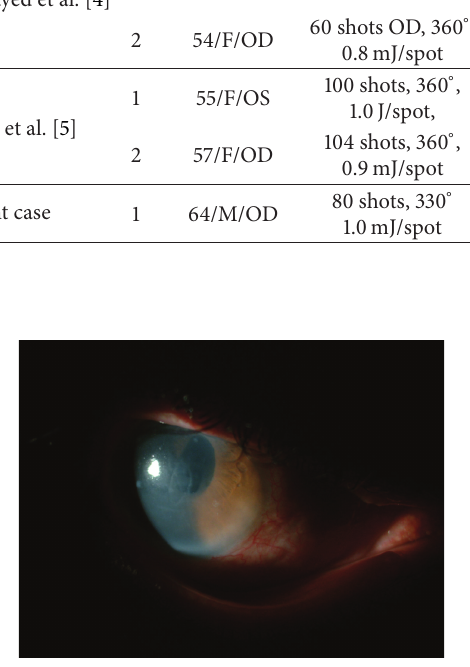
Figure 1: Diffuse corneal edema on slit-lamp examination of the patient’s right